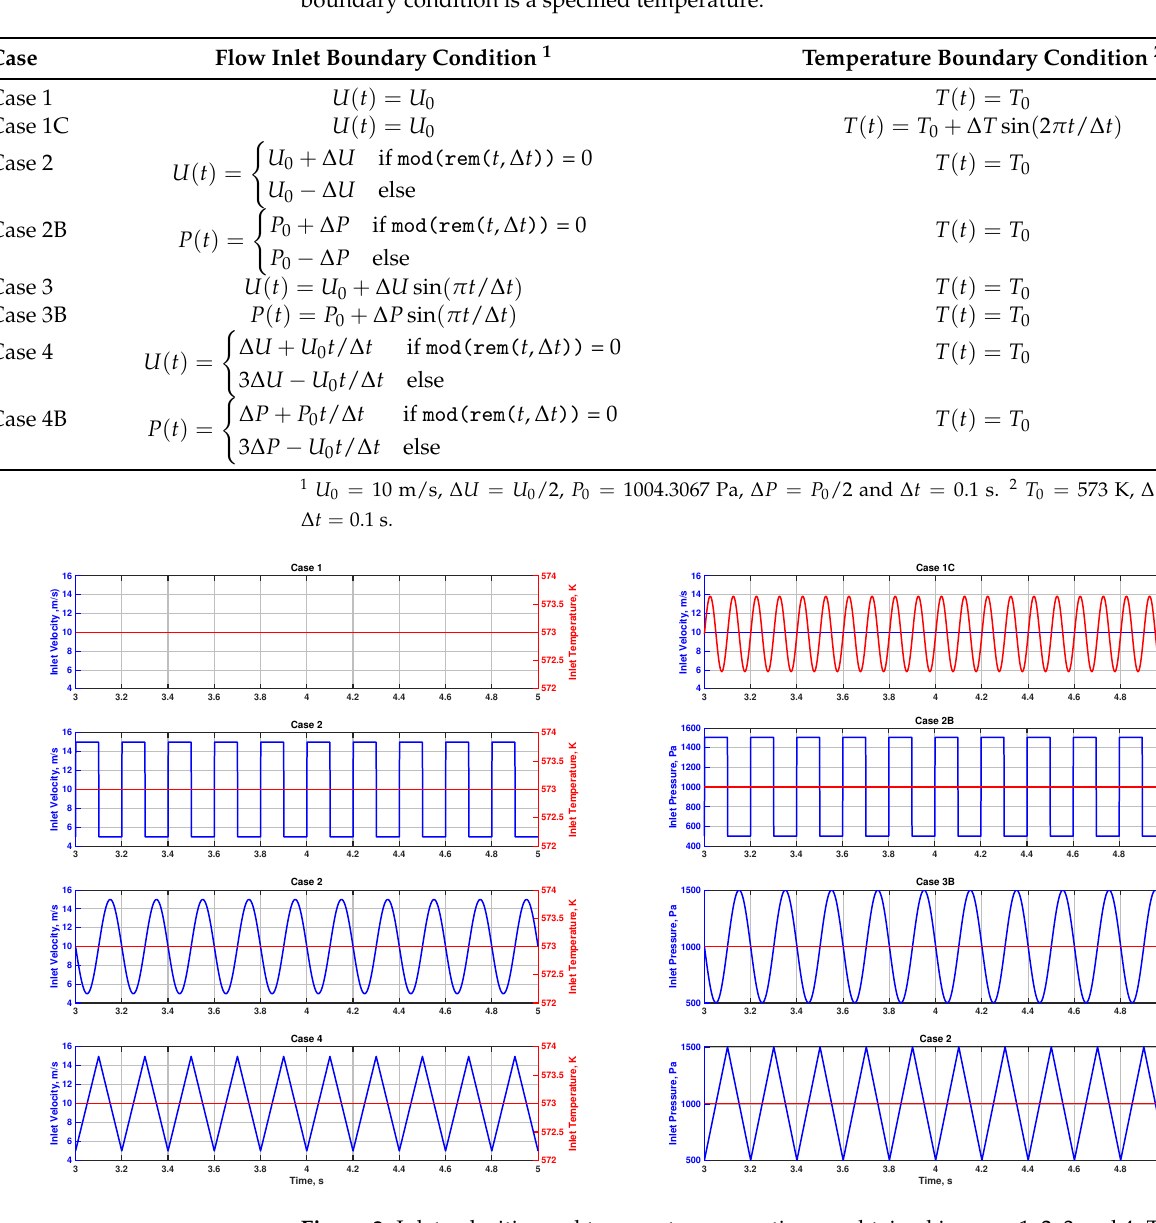
Table 3. The boundary condition specifications of the cases investigated in the present work. The flow inlet boundary condition is either a specified velocity or a specified pressure. The inlet temperature boundary condition is a specified temperature.